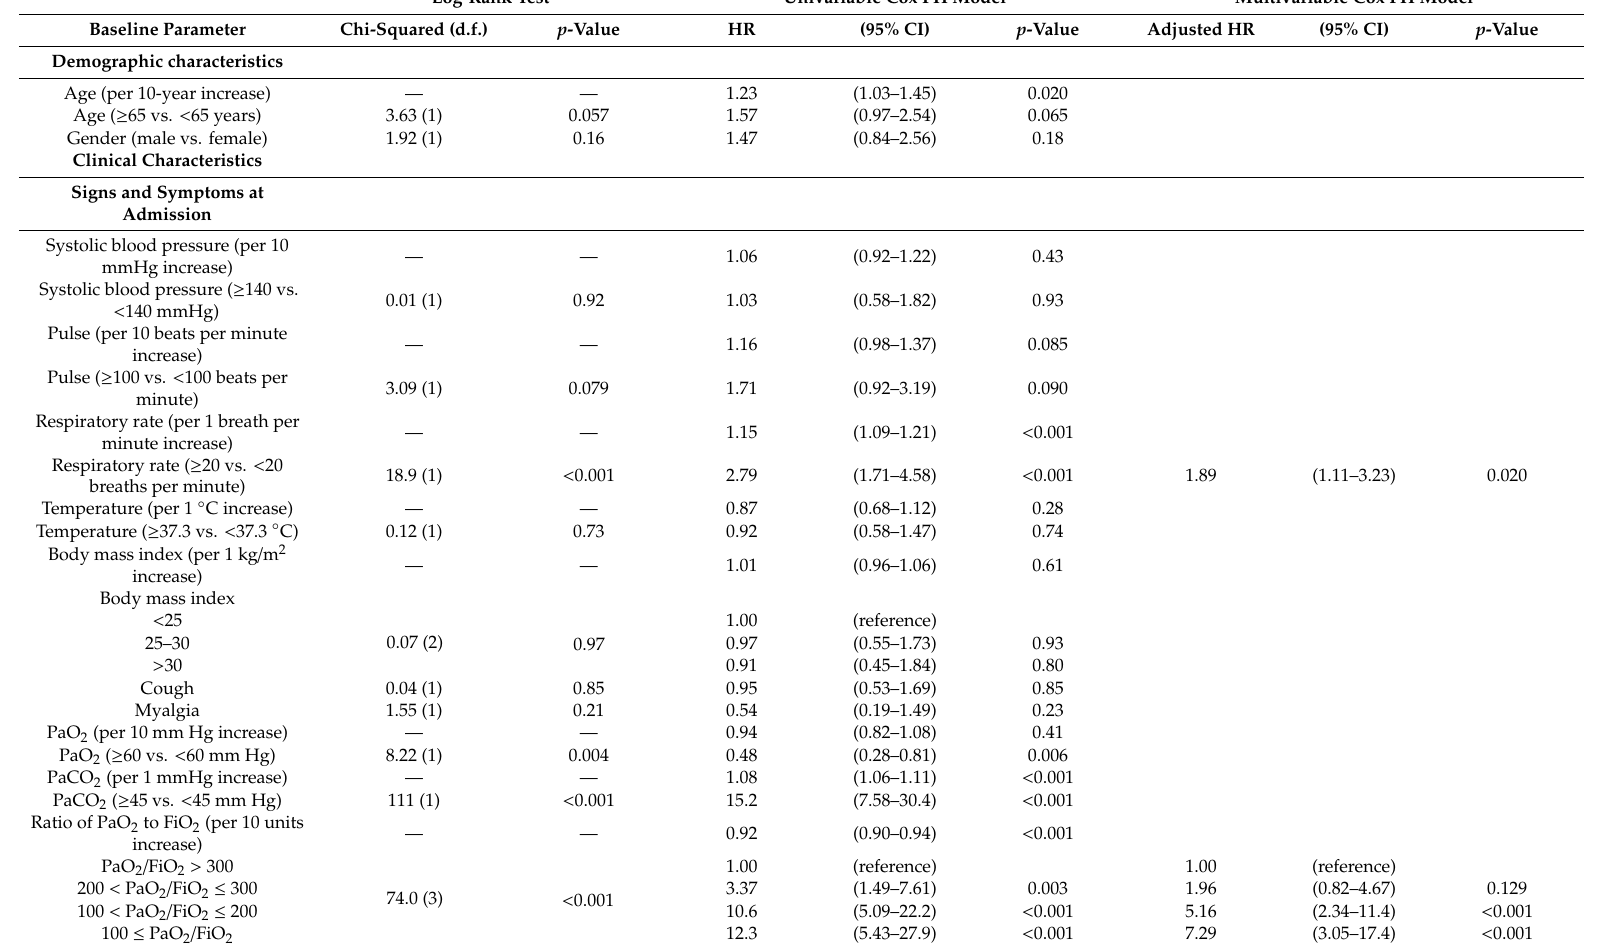
Table 2. Predictors of Clinical Deterioration Leading to “ICU Transfer or Death” in Hospitalized COVID-19 Patients: Results of Time-to-Event